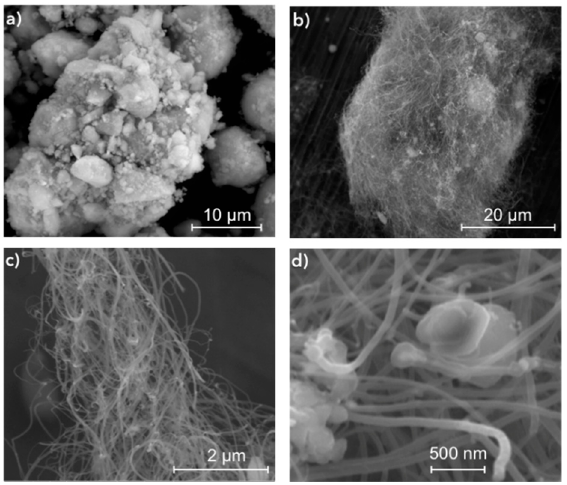
Figure 9. SEM of Ni/CeZrO 2 ( a ) before and ( b ‒ d ) after CH 4 decomposition at T = 700 °C under flowing 10 vol.% CH 4 /Ar for t = 3 h.